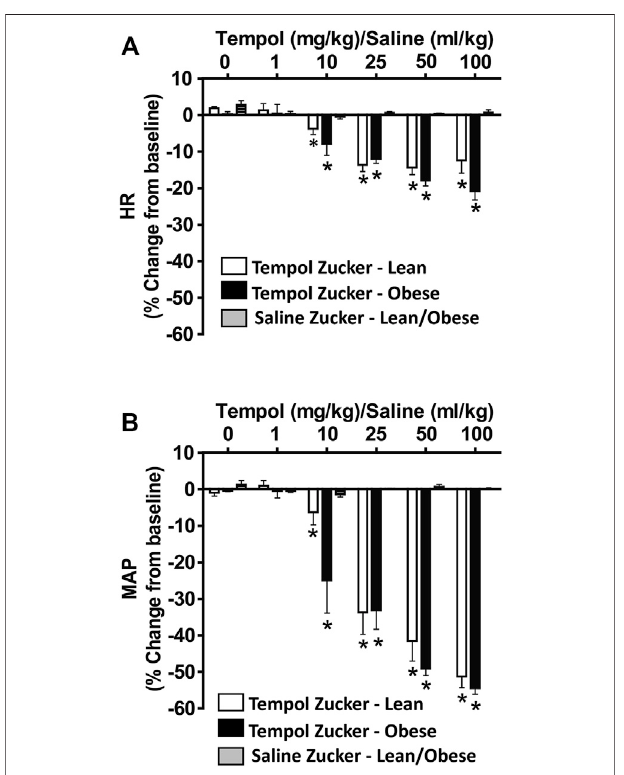
FIGURE 4 | Tempol elicited dose-dependent decreases in heart rate (HR) and mean arterial blood pressure (MAP) in iso fl urane-anesthetized animals that were similar in magnitude in obese and lean Zucker rats. HR and MAP were calculated from the arterial blood pressure waveforms in lean (open bars) and obese ( fi lled bars) Zucker rats. Cumulative bolus doses of Tempol (1 – 100 mg/kg, IV) were given to lean and obese Zucker rats. Tempol dose-dependently decreased HR (Panel A) and MAP (Panel B) in lean and obese Zucker rats. Repeated administration of saline (time control, shaded bars)hadnoeffectsonHRandMAPinleanandobeseZuckerrats.Valuesare presented as mean ± SEM. There were six rats in each of the obese and lean ZuckergroupsthatreceivedTempolwhereasbothlean( n =2)andObese( n = 2) Zucker rats received saline. * p < .05, different from saline controls (two-way ANOVA with Sidak multiple comparison tests). There were no differences in the responses elicited by Tempol in the obese and lean Zucker rats ( p > .05, for all comparisons; two-way ANOVA with Sidak multiple comparison